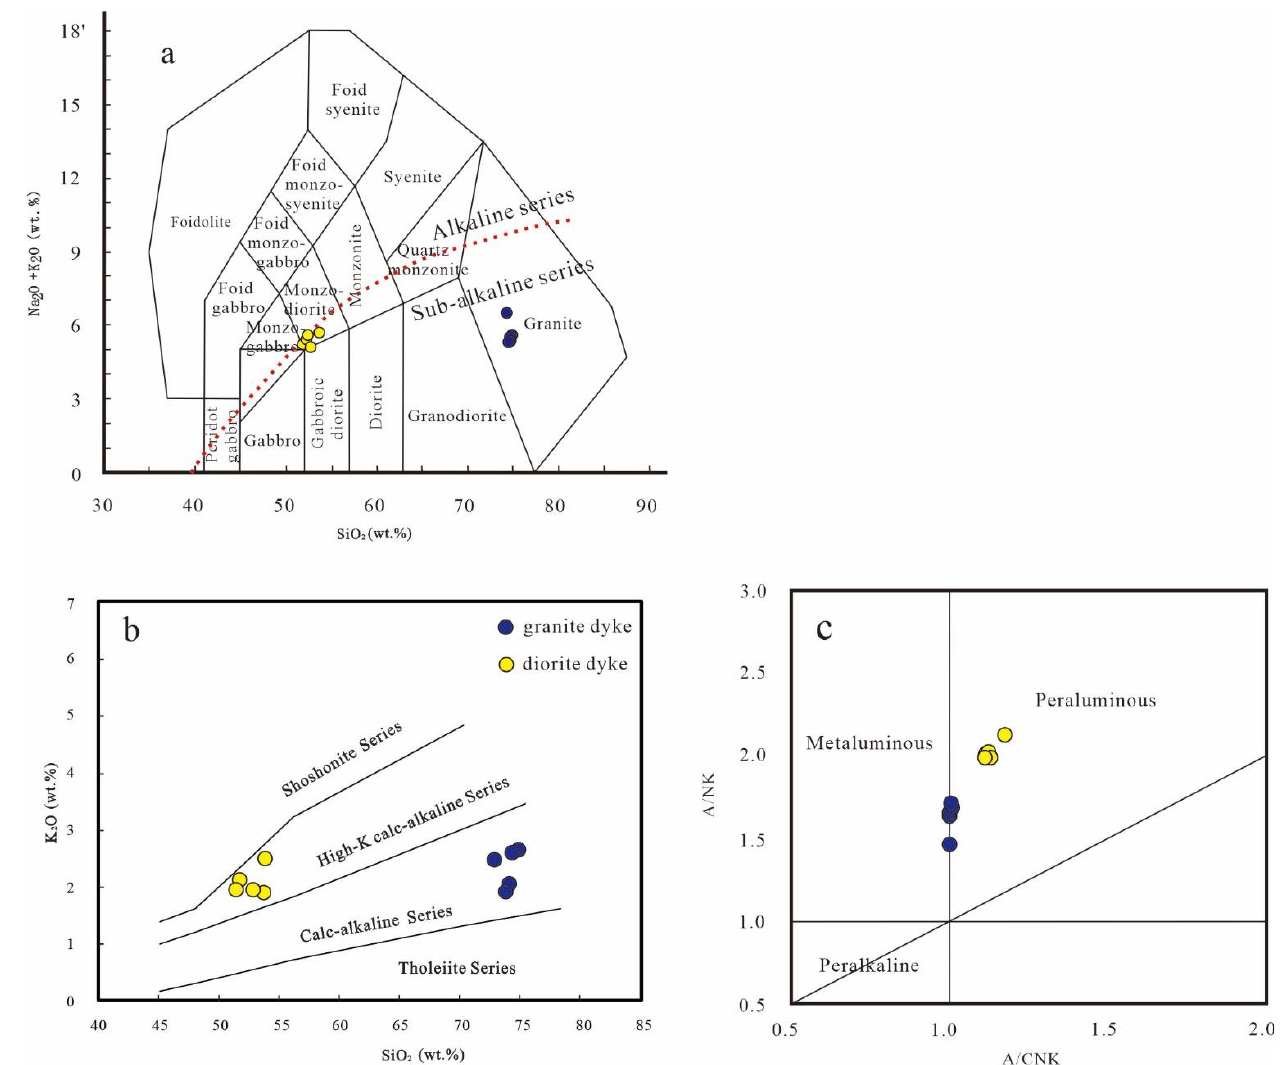
Figure 7. SiO 2 – (Na 2 O + K 2 O), SiO 2 – K 2 O diagrams and A/NK versus A/CNK. Diagram of the granite Figure 7. SiO 2 –(Na 2 O + K 2 O), SiO 2 –K 2 O diagrams and A/NK versus A/CNK. Diagram of the granite and diorite dyke samples. ( a ) Diagram of SiO 2 – (Na 2 O + K 2 O); (base map after Middlemost, [40]). ( b ) and diorite dyke samples. ( a ) Diagram of SiO 2 –(Na 2 O + K 2 O); (base map after Middlemost, [40]). Diagram of SiO 2 − K 2 O (after Peccerillo and Taylor [41]). ( c ) Diagram of A/NK − A/CNK (after Maniar ( b ) Diagram of SiO 2 –K 2 O (after Peccerillo and Taylor [41]). ( c ) Diagram of A/NK − A/CNK (after and Piccoli [42]). Maniar and Piccoli